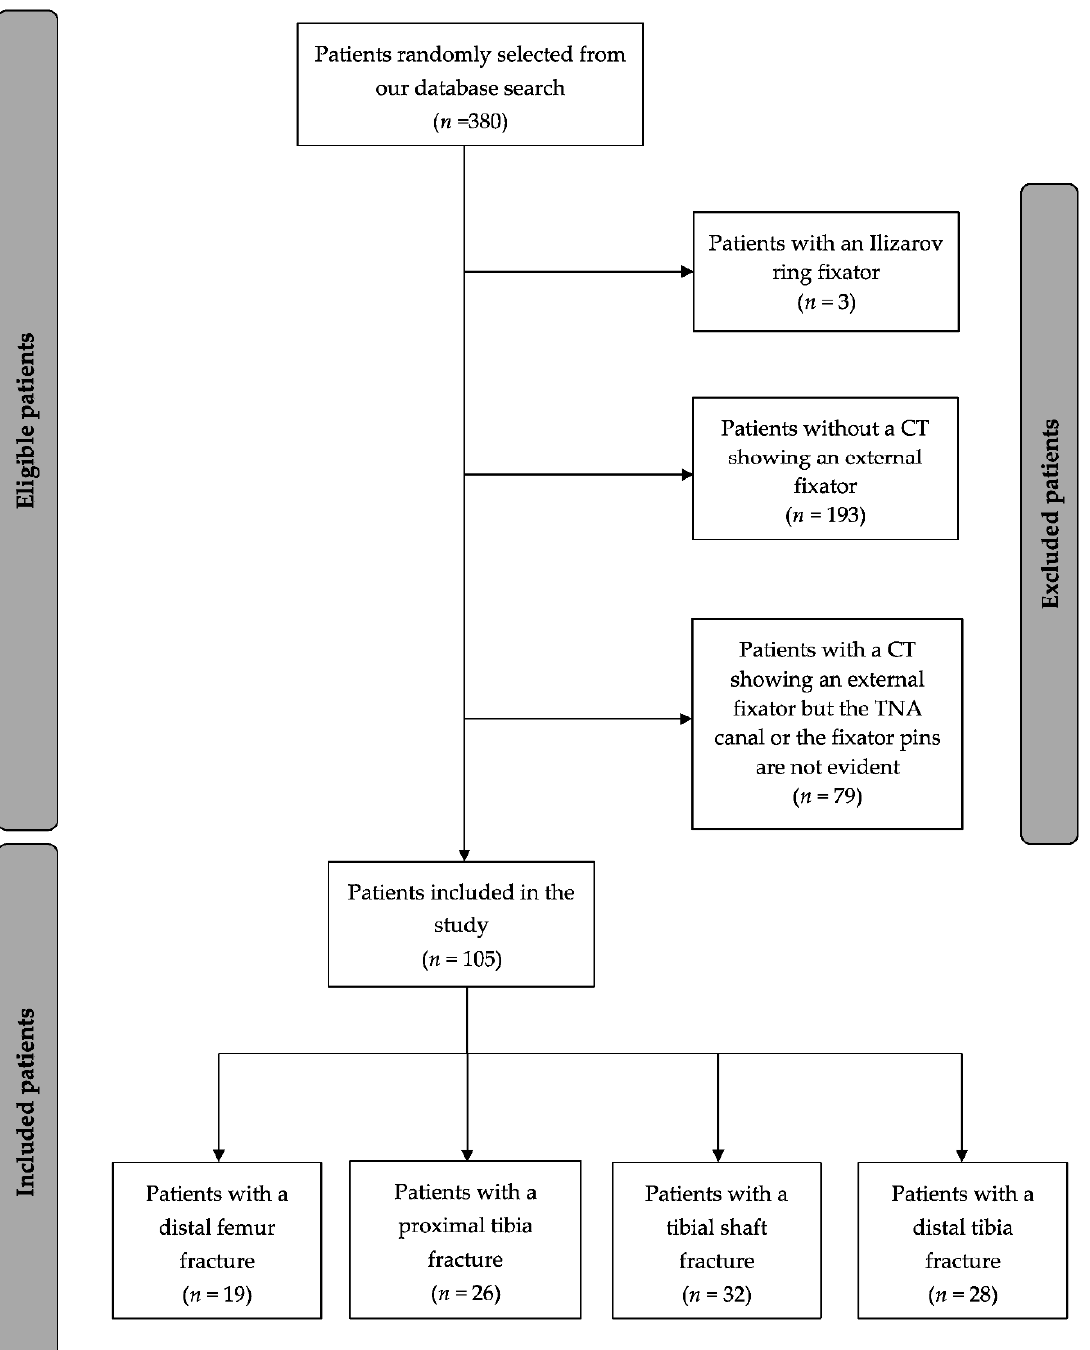
Figure 1. Flow diagram of the inclusion/exclusion process.